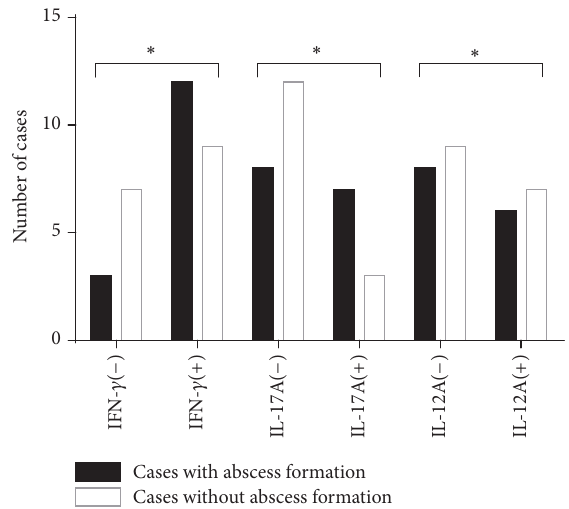
Figure 3: Production of IFN- 𝛾 , IL-12A, and IL-17A in cases with or without abscess formation. ( − ): low expression of cytokines; (+): high expression of cytokines. Fifteen patients had lesions with abscess formation, while 16 patients did not have them. More cases with high expressions of IFN- 𝛾 and IL-17A in stromal inflammatory cells could be found in patients with abscess formation. ∗ 𝑃 > 0.05